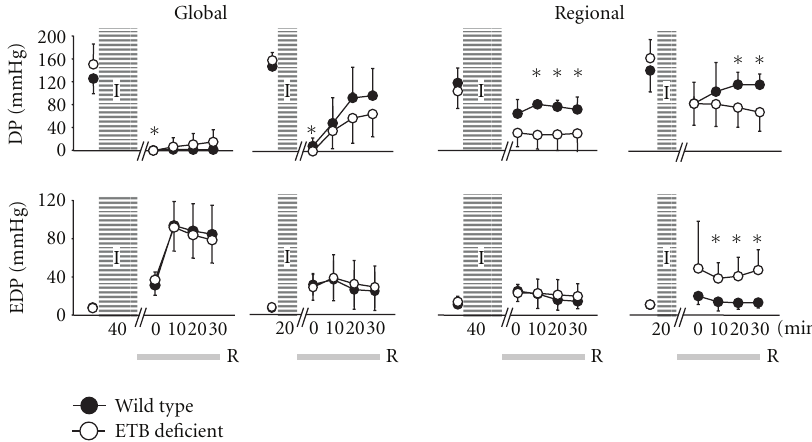
Figure 1: Left-ventricular-developed pressure (LVDP, upper) and end-diastolic pressure (LVEDP, lower) after ischaemia (I)/reperfusion (R) in wild-type (dark dots) and ETB-deficient rats (white dots). Asterisk denotes significant di ff erences between the two groups.